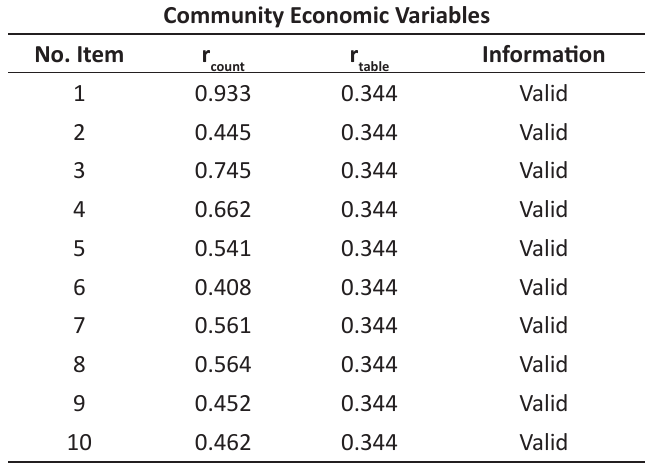
Table 5: Results of the Validity Test of Community Economic Variables